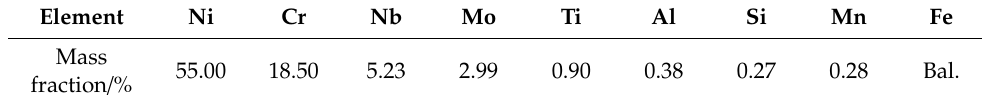
Table 1. Chemical composition of Inconel 718 alloy powder. Table 2. Composition ratio of mixed powder (wt.%).